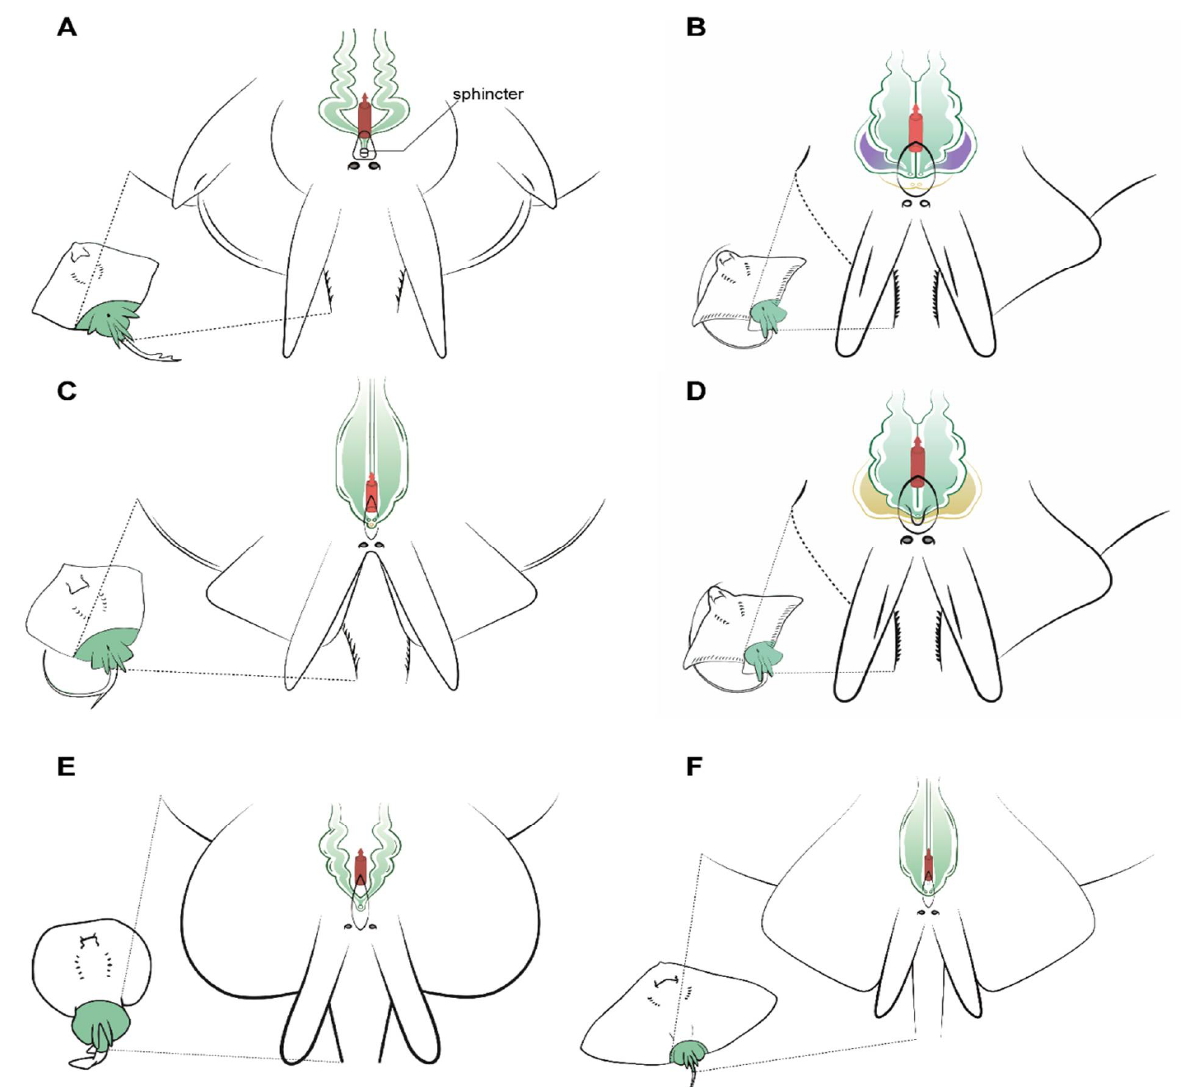
Figure 6. Specific male anatomy. Species-specific morphologies in batoids with relevance to performing sperm extraction, such as the pores leading to the seminal vesicles. Reproductive, excretory, and digestive systems are marked with different colours. Green: the seminal vesicle and ductus deferens; purple: the alkaline gland; yellow: the excretory system; red: the access to the digestive system. The grey circles are the abdominal pores that facilitate communication between the pleuroperitoneal cavity and the exterior. ( A ) model observed in genus Raja , with a unique sphincter on its urogenital papilla; ( B ) model observed in common stingray Dasyatis pastinaca , with two pores leading to the seminal vesicle and one pore to the urinary system; ( C ) model observed in common eagle ray Myliobatis aquila showing four different pores, with the two upper pores facilitating access to the seminal vesicle; ( D ) in bull ray Aetomylaeus bovinus , there are only two pores: one in the cranial part of the urogenital papilla leading to the seminal vesicle and one leading to the urinary system; ( E ) model observed in the marbled electric ray Torpedo marmorata , where there are two pores to access the seminal vesicles which are a widening of the ductus deferens; ( F ) the spiny butterfly ray Gymnura altavela reproductive system is similar to that of D. pastinaca , with two different pores to access the reproductive